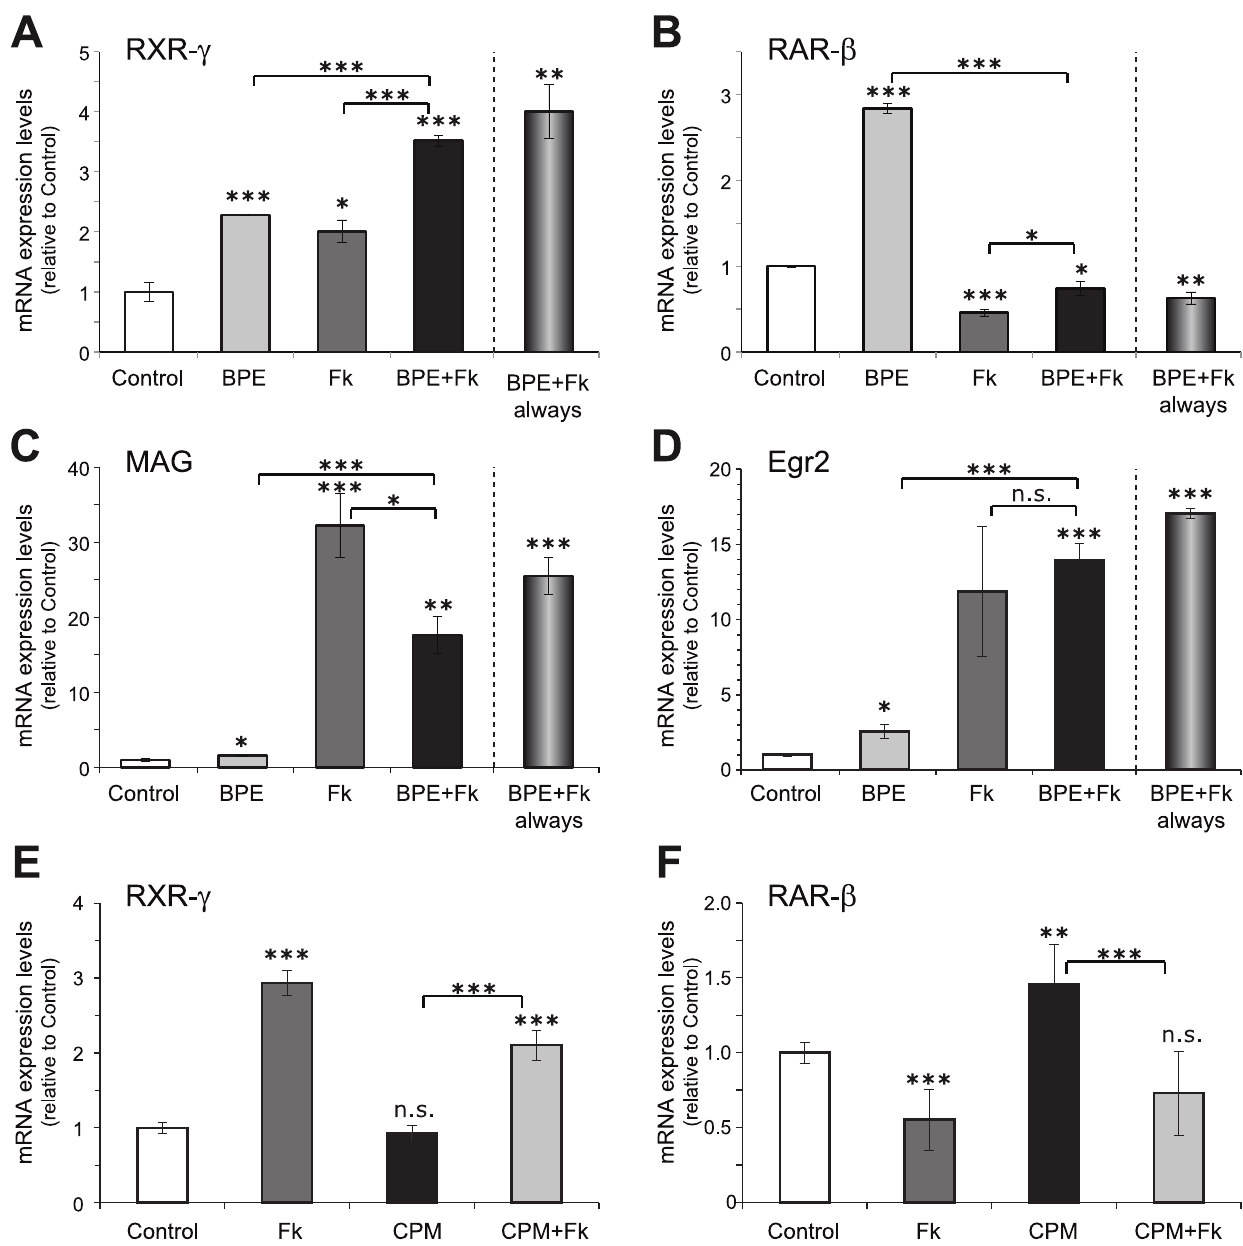
Figure 2. RXR- c levels in SCs are induced by axonal contact mimickers. ( A – D ) Isolated SCs were adapted for 24 hours to the absence of the axonal contact mimickers BPE and forskolin and subsequently treated for 48 hours with 2 m M forskolin (Fk), 60 m g/ml BPE or the combination of both, and the levels of RXR- c ( A ), RAR- b ( B ), MAG ( C ) and Egr2 ( D ) were analyzed by Q-RT-PCR. In all instances, the levels reached after the acute combined treatment were compared to SCs continuously grown in the presence of BPE and Fk (BPE + Fk always). ( E – F ) SCs were adapted for 24 hours to the absence the axonal contact mimickers and subsequently treated for 48 hours with 2 m M forskolin (Fk), 5 m M cyclopamine (CPM) or the combination of both, and the levels of RXR- c ( E ) and RAR- b ( F ) were analyzed by Q-RT-PCR. All values are shown as the mean 6 SD relative to their respective controls (cells grown in the presence of vehicle). Significance was assessed by unpaired Student’s t -test. n.s.: non-significant; *: p , 0.05; **: p , 0.01; ***: p ,